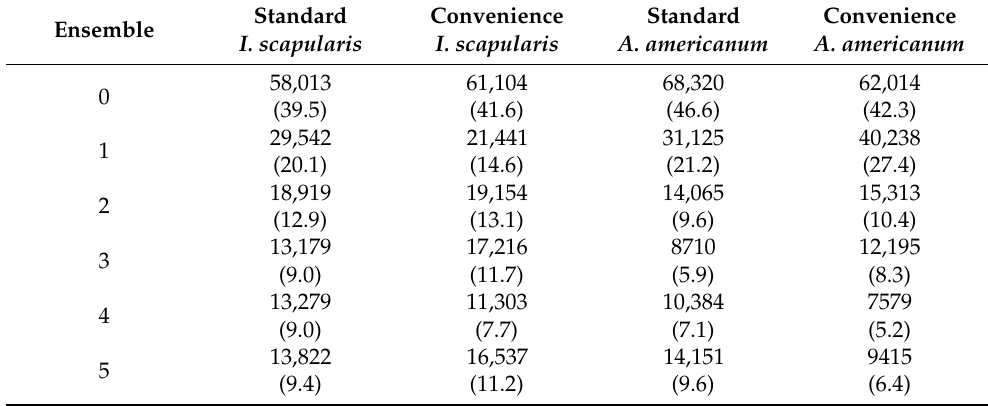
ience samples of I. scapularis ).